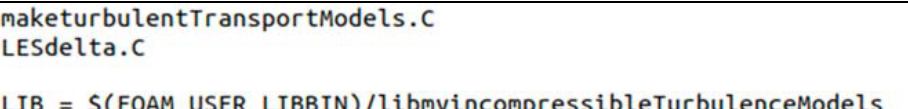
Figure 2. The files source code.